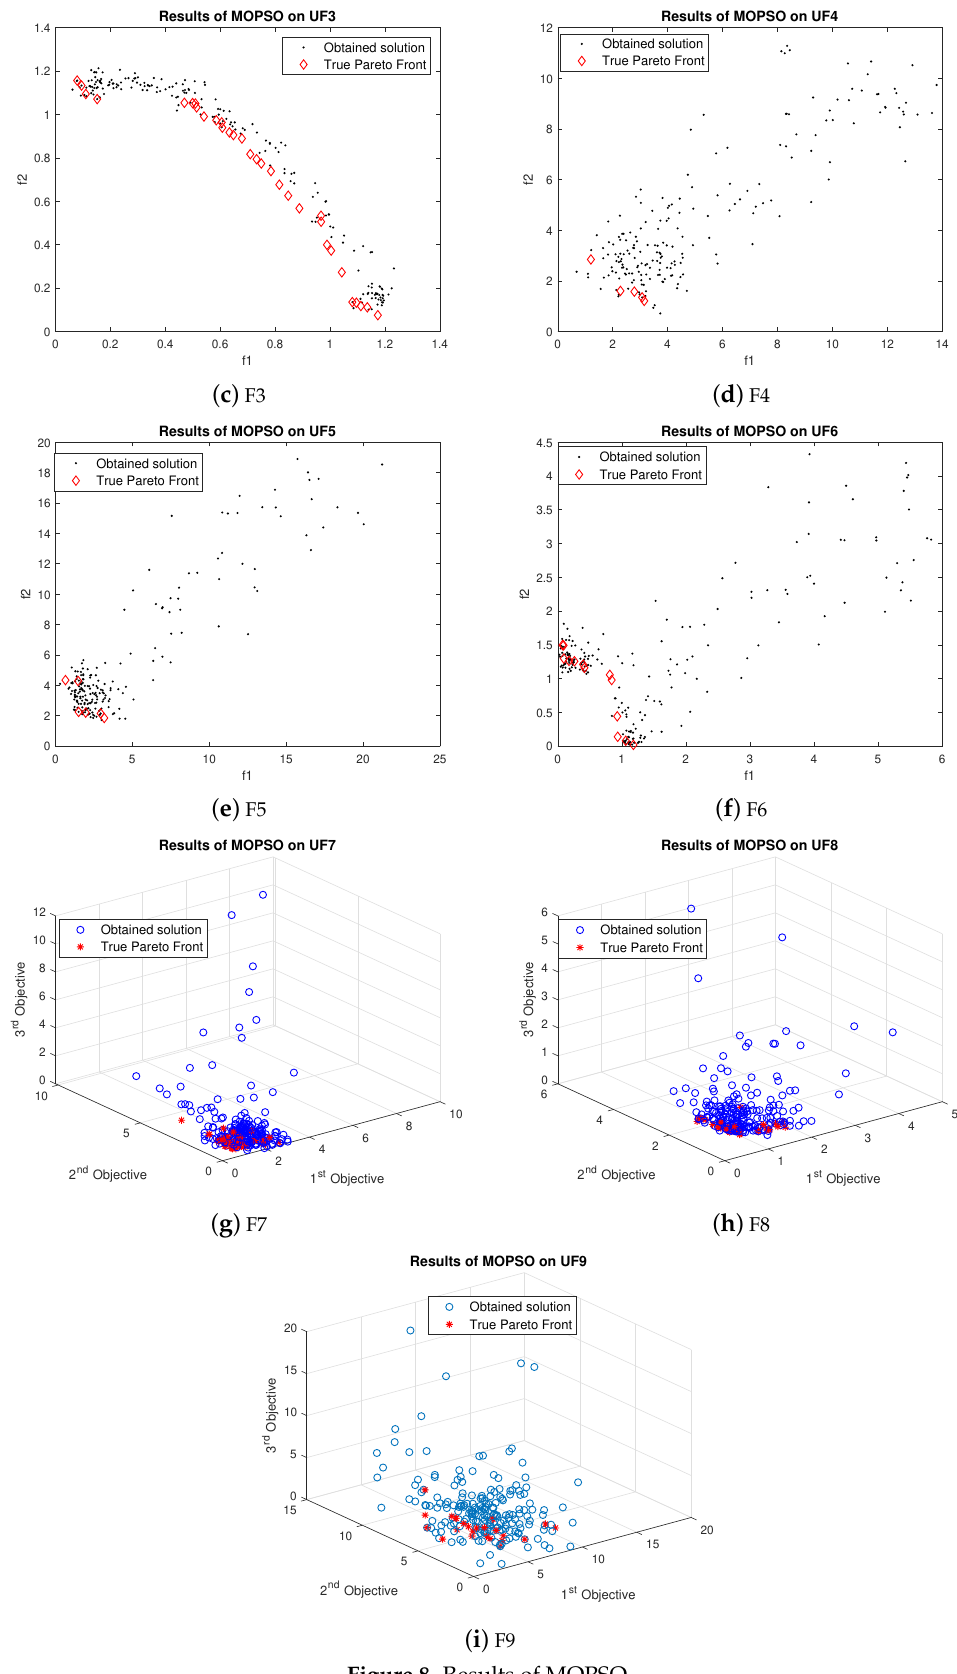
Figure 8. Results of